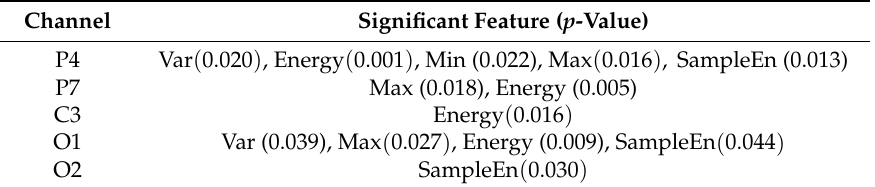
Table 1. Significant features obtained from the EEG time domain